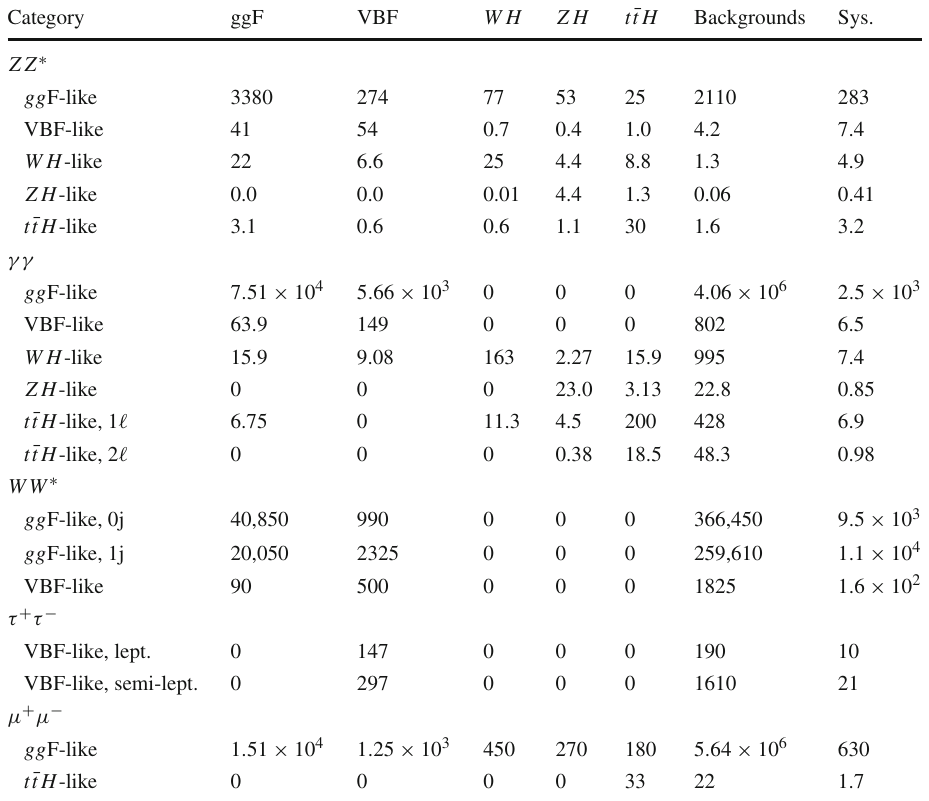
Table 3 Number of signal and background events in each X -like production channel and decay for ATLAS-HL at 14 TeV LHC with 3000 fb − 1